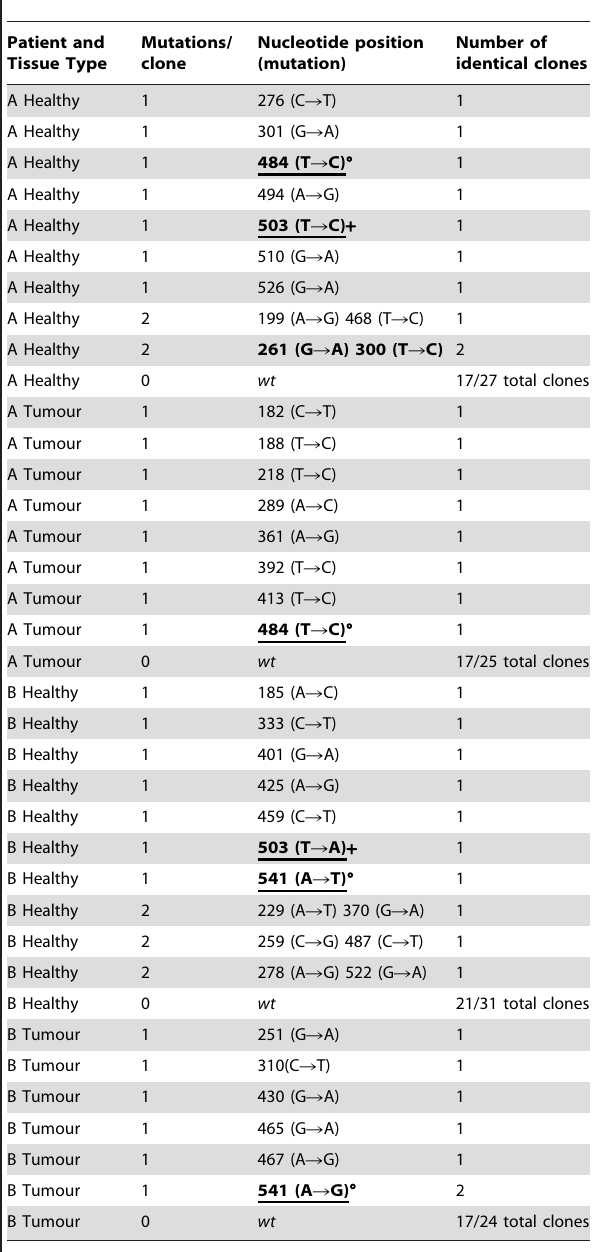
Table 2. Mutations in G6PD transcripts in tumour and nearby healthy